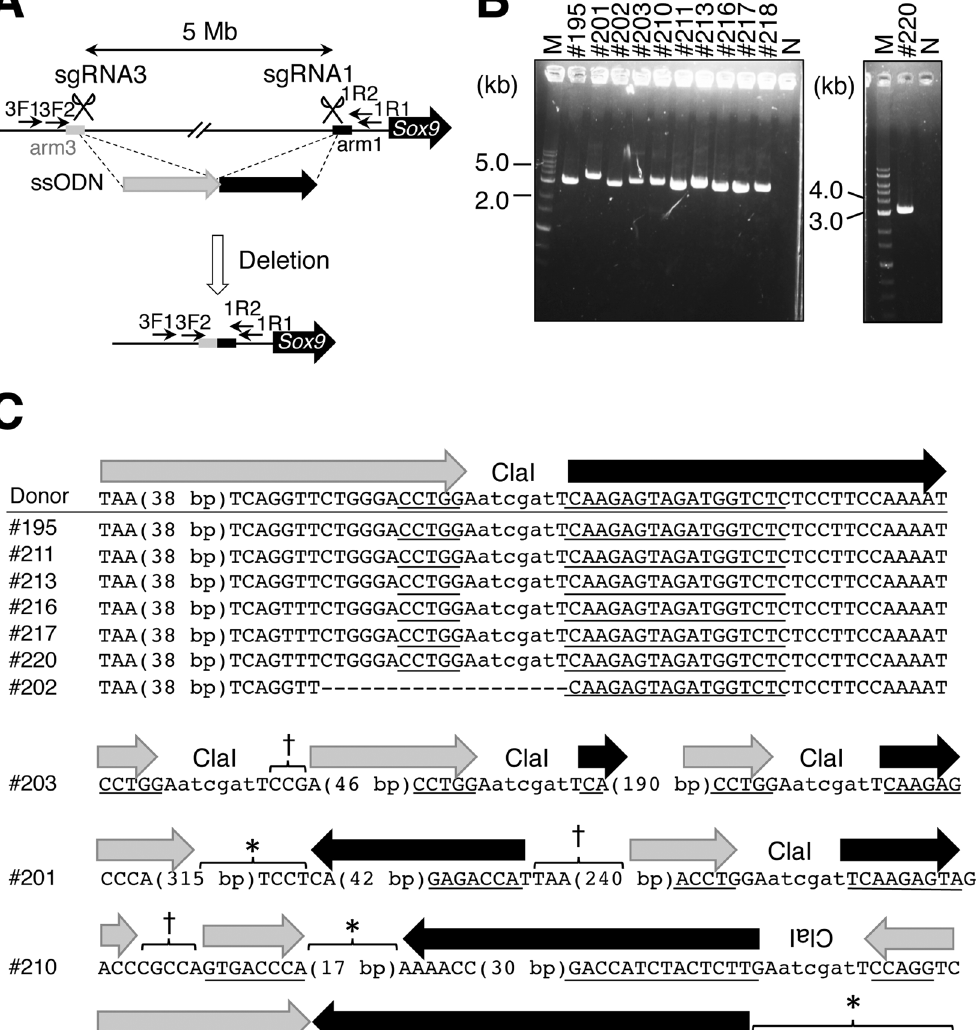
Figure 3. Generation of mutant mice with a 5-Mb deletion using an ssODN template. ( A ) Schematic representation of the 5-Mb region upstream of Sox9 . The black line represents genome sequence. Homology arms in the ssODN are indicated with black and gray boxes. PCR primers are indicated with arrows. Positions of sgRNA recognition sequences are denoted with scissors. ( B ) An agarose gel electrophoretogram image of PCR products amplified using 3F1 and 1R1 primers and DNA prepared from embryos injected with the ssODN template. Embryo IDs are shown above images with the # sign. M: a 1-kb DNA ladder (markers); N: no template control. ( C ) Sequences of the ssODN template and of embryos injected with the ssODN template are aligned. Positions corresponding to arms and ClaI recognition sequence are indicated at the top. Parts of gRNA recognition sequences are underlined. The asterisk indicates an unknown sequence. The obelisk indicates genomic sequence nonhomologous to the ssODN or to the internal sequence flanked by sgRNA3 and sgRNA1. Black and gray arrows correspond to those in ( A